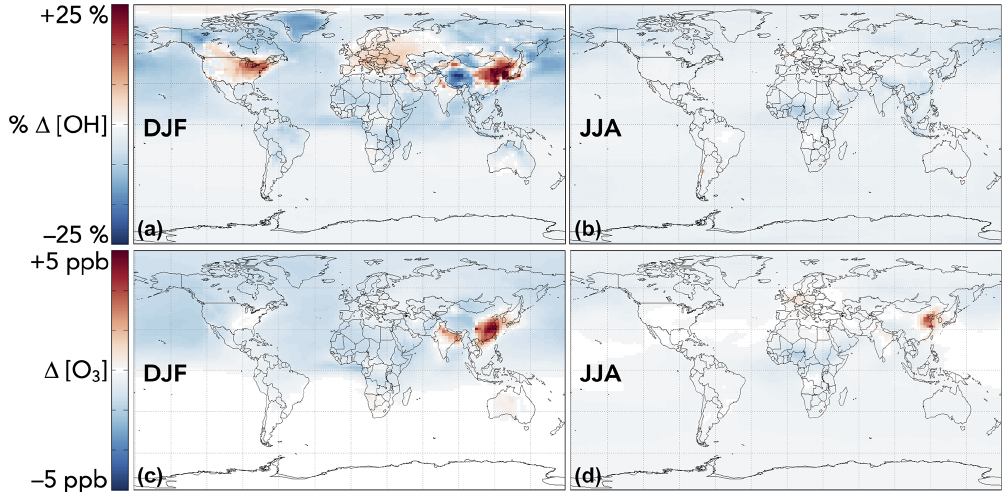
Figure 13. Seasonal effects of aromatic chemistry on OH and ozone concentrations. Panels show the relative (for OH) and absolute (for ozone) differences in mean concentrations below 1km altitude between GEOS-Chem simulations with GC13 aromatic chemistry and